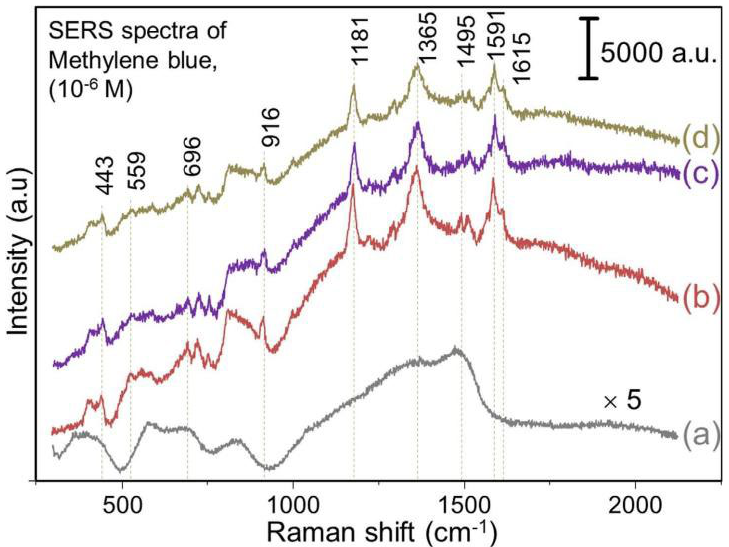
Figure 17. ( a ) Raman spectrum of Ti 3 C 2 T x after soaking in MB dispersed in ethanol and subsequent drying. SERS spectra of MB with ( b ) Ag@, ( c ) Au@ and ( d ) Pd@MXene. Reprinted with permission from [70]. Copyright 2016 Springer Nature.